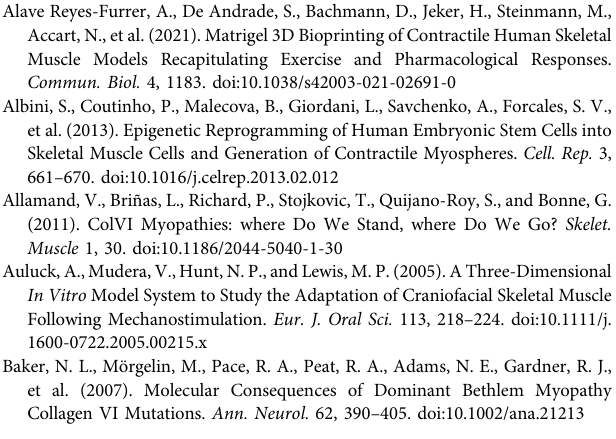
Supplementary Table S3 | List of most relevant 3D muscle